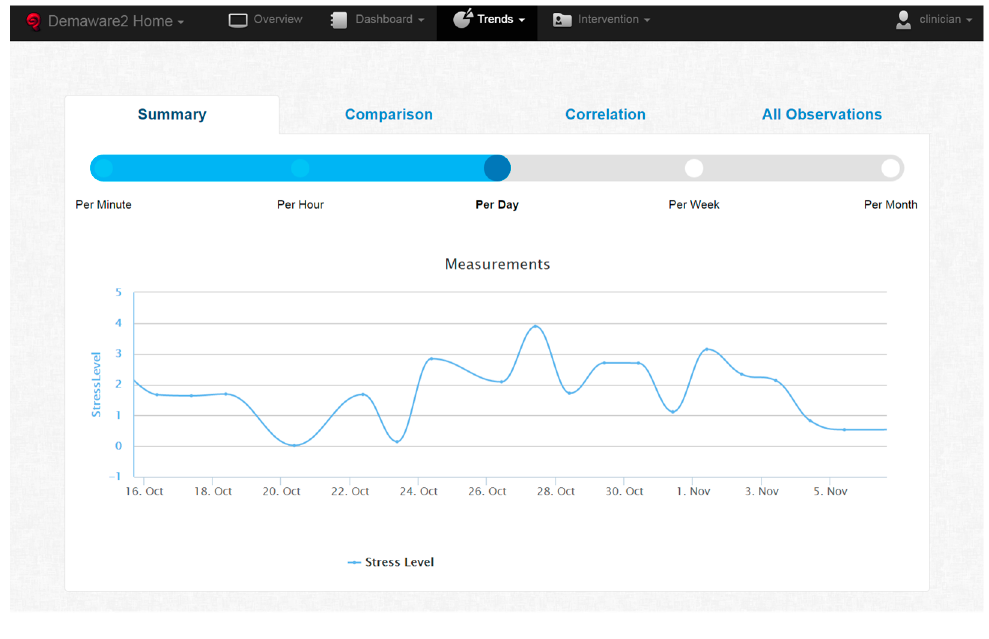
Figure 7. Web application showing daily average stress level.